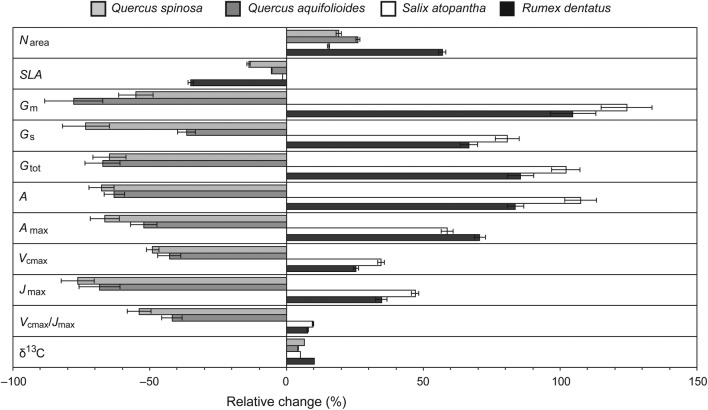
Relative effect of an increase in elevation from 2500 to 3500 m a.s.l. on photosynthetic, morphological and compositional characteristics of Q. spinosa, S. atopantha and R. dentatus from this study and Q. aquifolioides from the study of Feng et al. (2013). Error bars indicate 1 SE.